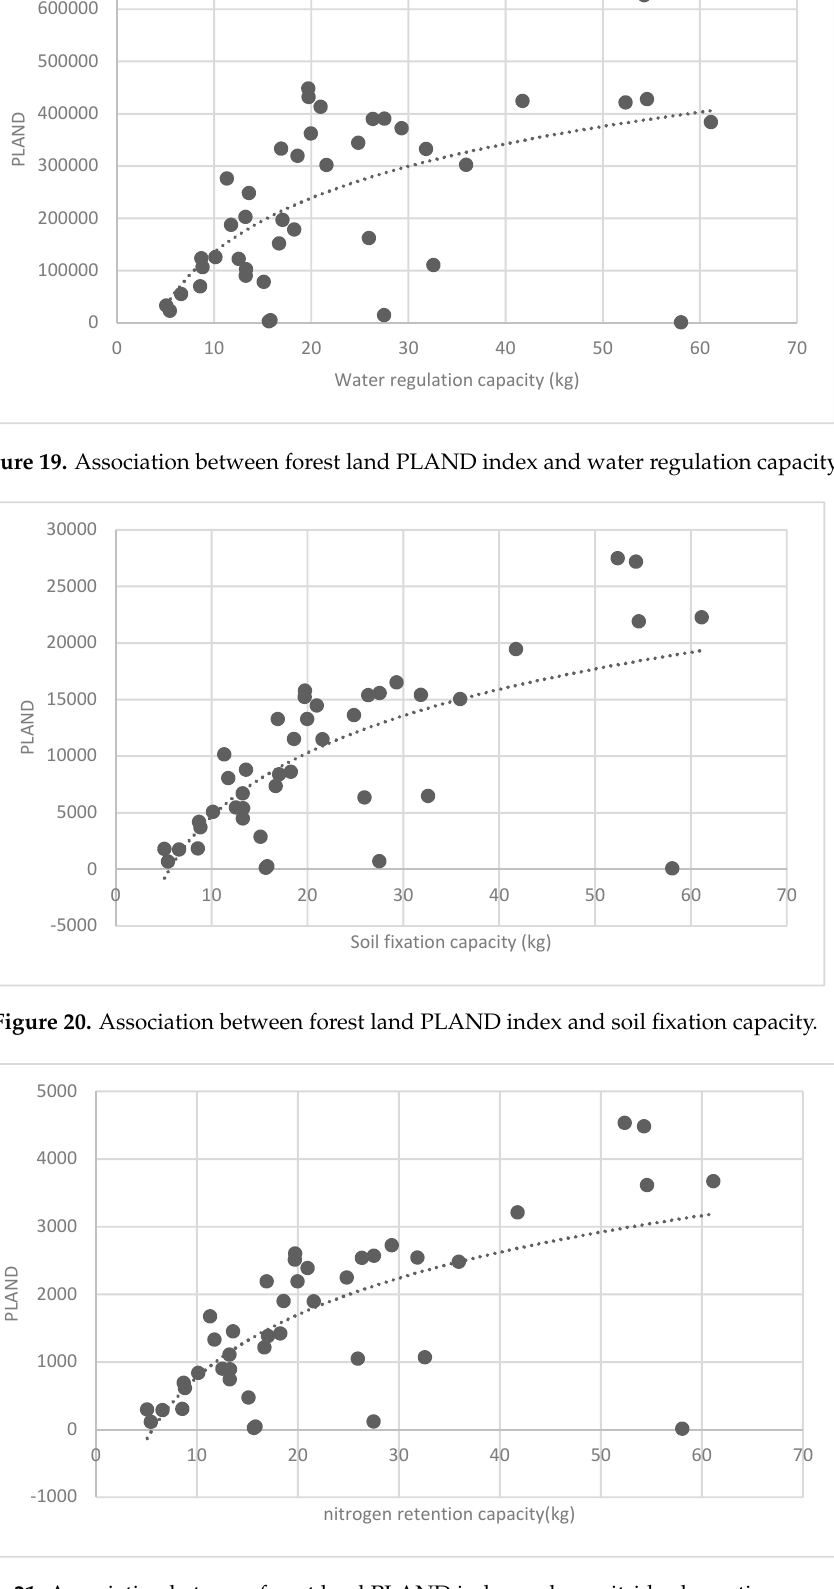
Figure 21. Association between forest land PLAND index and oxynitride absorption capacity.